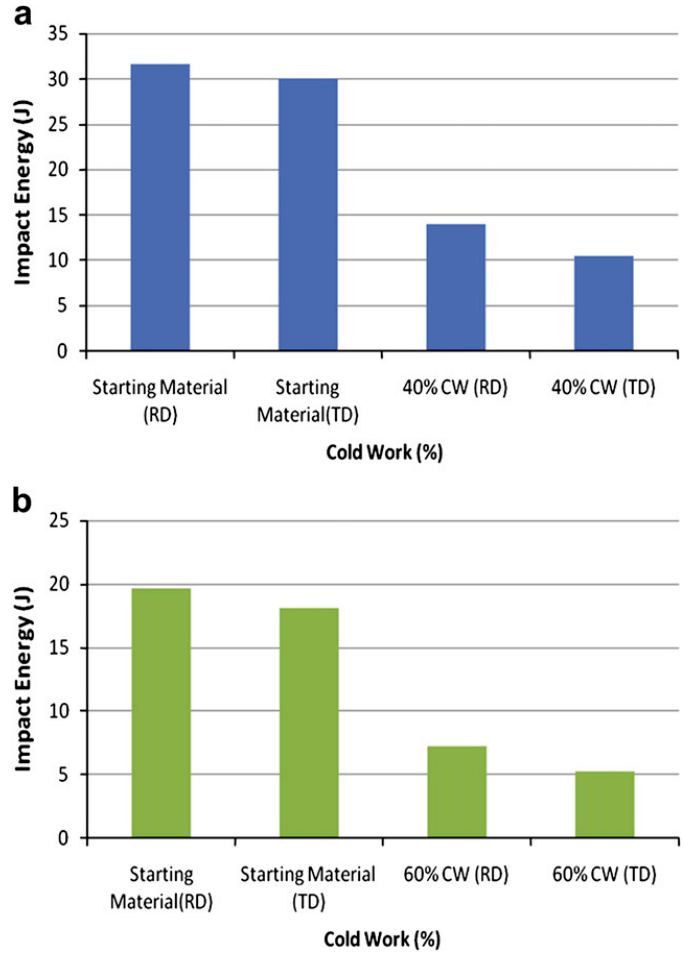
Figure 11. Effects of cold rolling and anisotropy on impact energy of Al alloys: ( a ) 40% cold working (CW) (Plate thickness = 7.5 mm), ( b ) 60% CW (Plate thickness = 5 mm) [48].